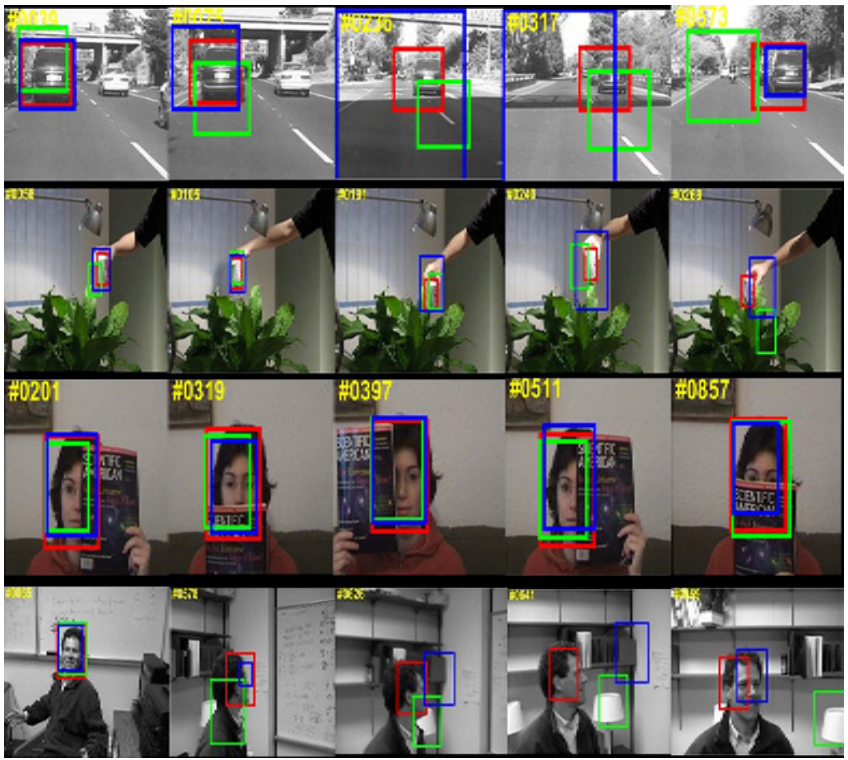
Figure 3. OTB experimentation screenshot of parts of video frame s in some datasets (TB-50 Se- quences, Wu et al.